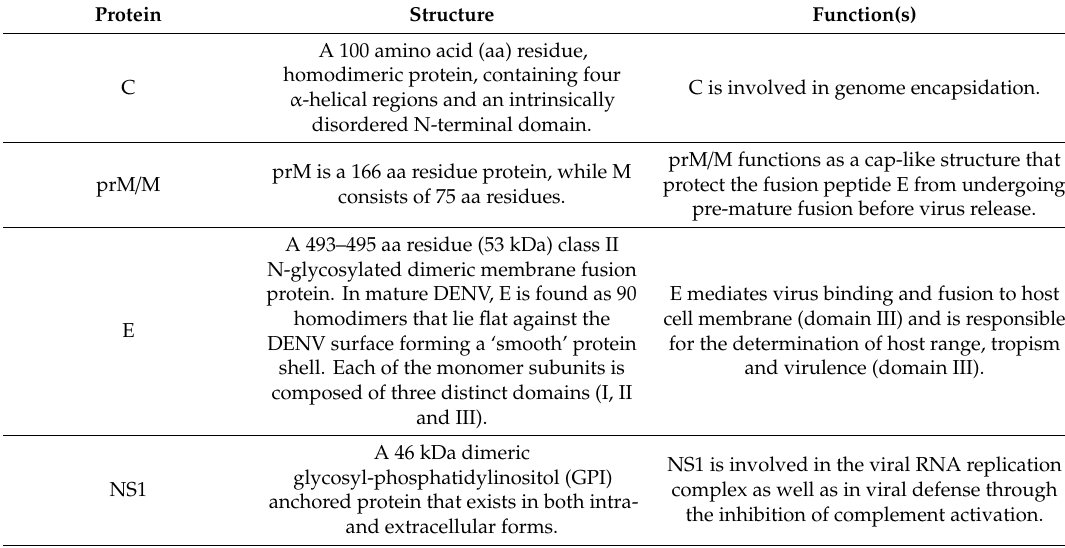
Table 1. Description of the structural and non-structural proteins of dengue virus (DENV). Protein Structure